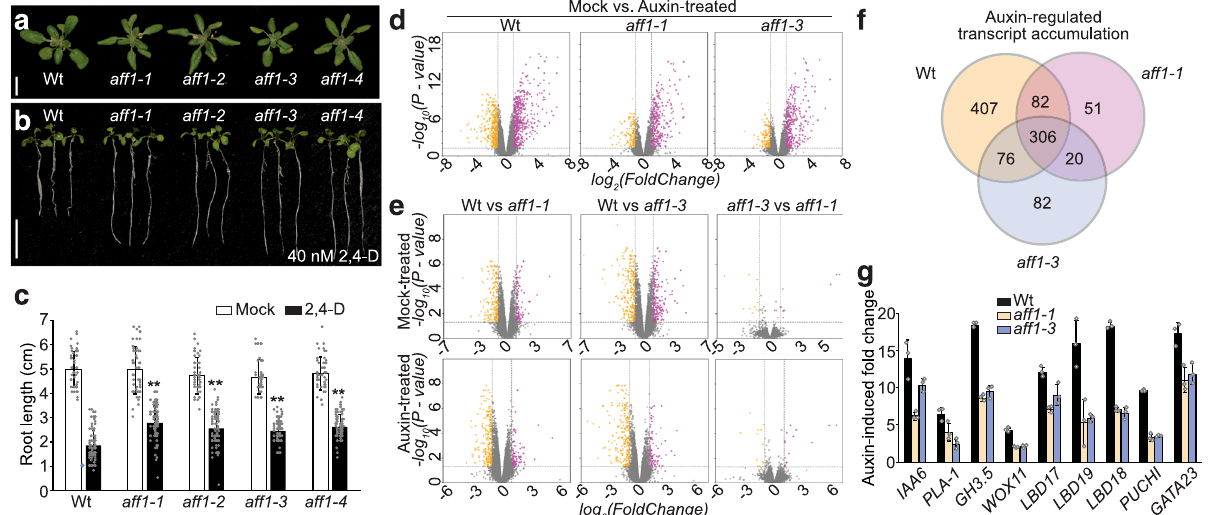
Fig. 6 aff1 exhibits developmental defects and attenuated auxin responsiveness. a Photograph of 22d-old wild type (Wt; Col-0), aff1-1 , aff1 – 2 , aff1 – 3 , and aff1 – 4 plants. Scale bar = 1 cm. b Photograph of 9d-old wild type (Wt; Col-0), aff1-1 , aff1 – 2 , aff1 – 3 , and aff1 – 4 seedlings grown on media supplemented with 40 nM 2,4-D. Scale bar = 1 cm. c Mean primary root lengths of 9d-old wild type (Wt; Col-0), aff1-1 , aff1-2 , aff1 – 3 , and aff1 – 4 seedlings vertically grown on media supplemented with mock (EtOH) or 40 nM 2,4-D. n = 80 biologically independent seedlings were examined. Data are mean ± SD from three independent experiments and gray dots represent the individual values. The statistical signi fi cance was determined by a two-sided Student ’ s t -test (Paired two sample for means). P values = 0.9815 ( aff1-1_ mock ) , 0.3943 ( aff1-2_ mock ) , 0.1653 ( aff1 – 3_ mock ) , 0.8700 ( aff1 – 4_ mock ) , 7.50E-17 ( aff1-1_ 2,4-D), 1.315E-11 ( aff1-2_ 2,4-D), 4.355E-12 ( aff1-3_ 2,4-D), and 7.405E-13 ( aff1-4_ 2,4-D). ** P < 0.01 when compared to Wt. d Volcano plots displaying pairwise